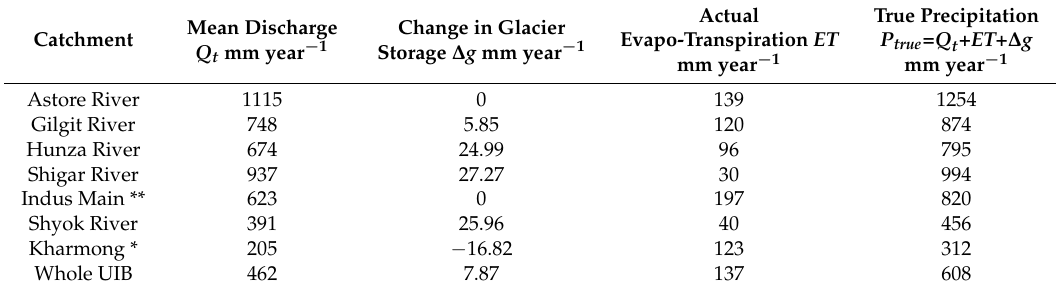
Table 6. Estimation of true precipitation (Equation (5)) for each catchment of the UIB.